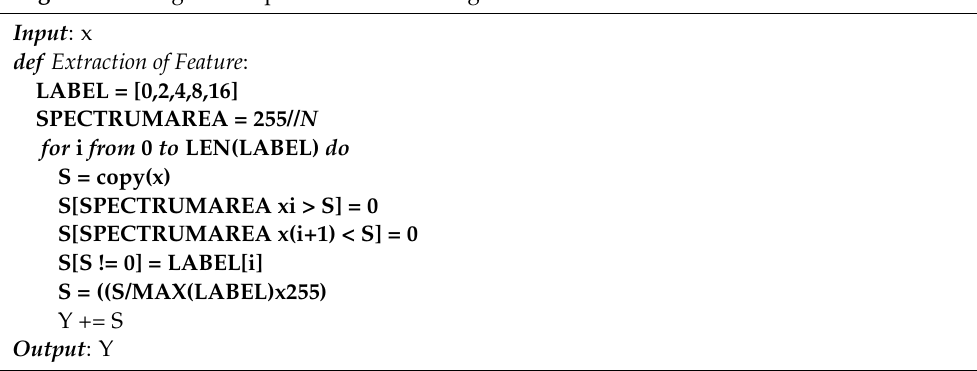
Algorithm 1 Brightness Spectrum Division